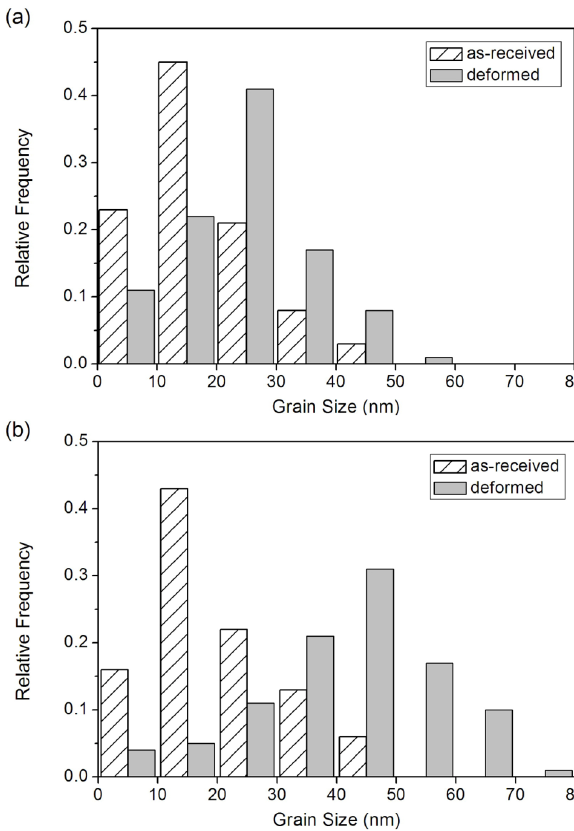
Figure 3: Statistical grain size distributions for the as-received and deformed ( ϵ = 0.15 ) samples: (a) NC Ni; (b) NC Ni-Fe